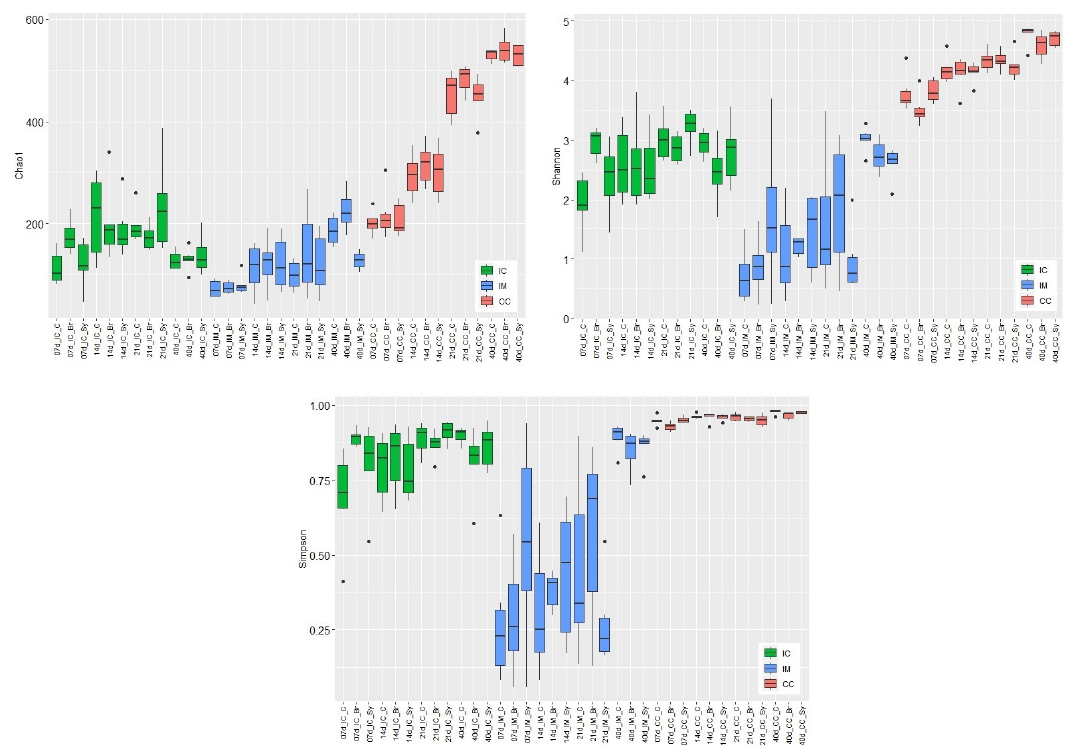
Figure 1. Effects of dietary treatments (C—Control, Br—Broilact ® , Sy—Synbiotic feed additive) and age of birds on the alpha diversity of ileal chymus (IC), ileal mucosa (IM), and caecal chymus (CC) microbiota in broiler chickens. Boxplots representing alpha diversity by Chao1 estimator, Shannon, and Simpson indexes. Boxes represent the median, the 25th, and the 75th percentiles of the groups. Alpha diversity indices at different taxonomical levels and in different intestinal samples (IC, IM, and CC) were compared using two-way ANOVA test with Tukey’s HSD multiple group comparison’s post hoc test, using the dietary treatments (C, Br and Sy) and the age of birds (7, 14, 21, and 40 day) as main factors. The differences were considered significant at a level of p ≤ 0.05. Dots represent the outlier